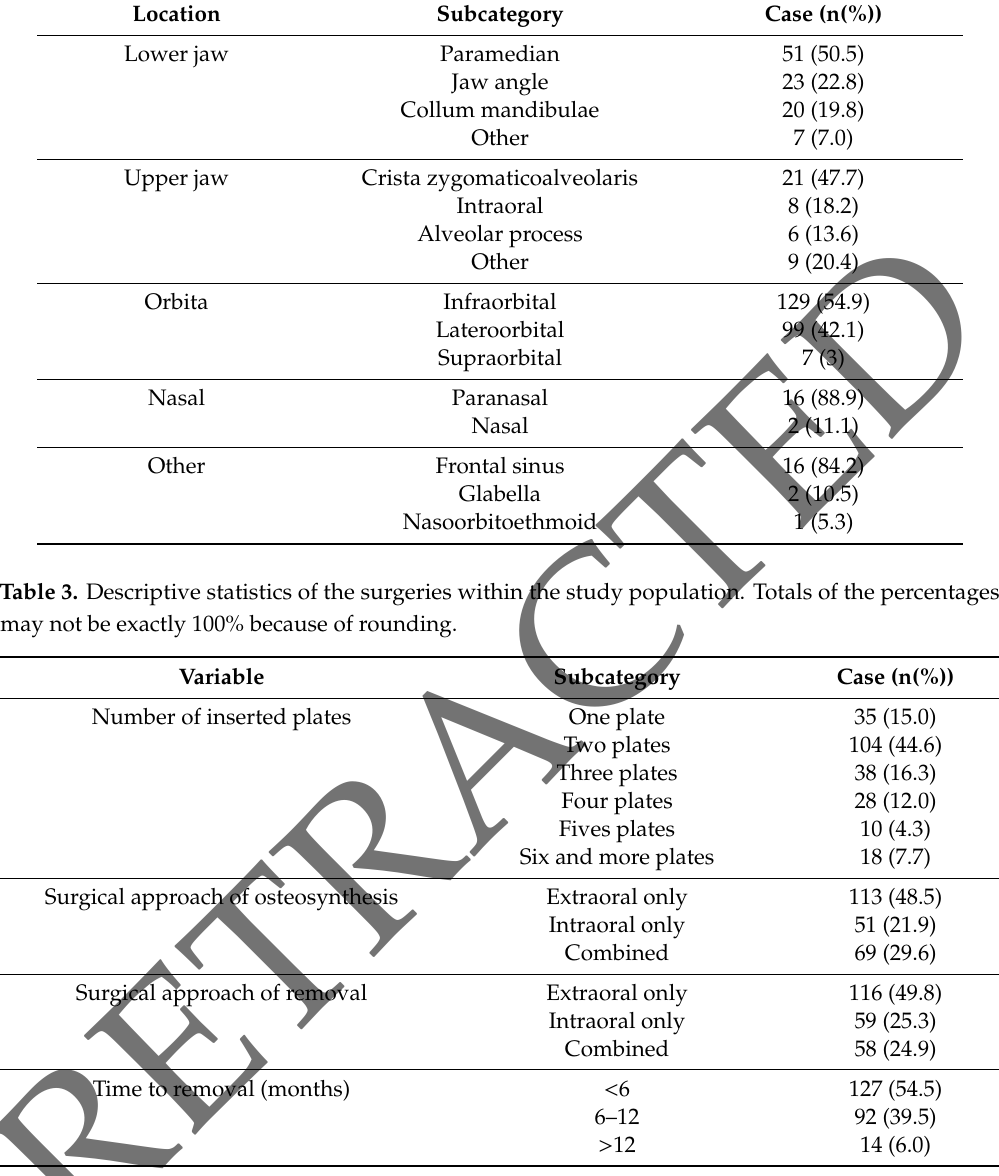
Table 2. Location of the inserted plates. The number of patients who had plates inserted at a specific location are indicated. Totals of the percentages may not be exactly 100% because of rounding.